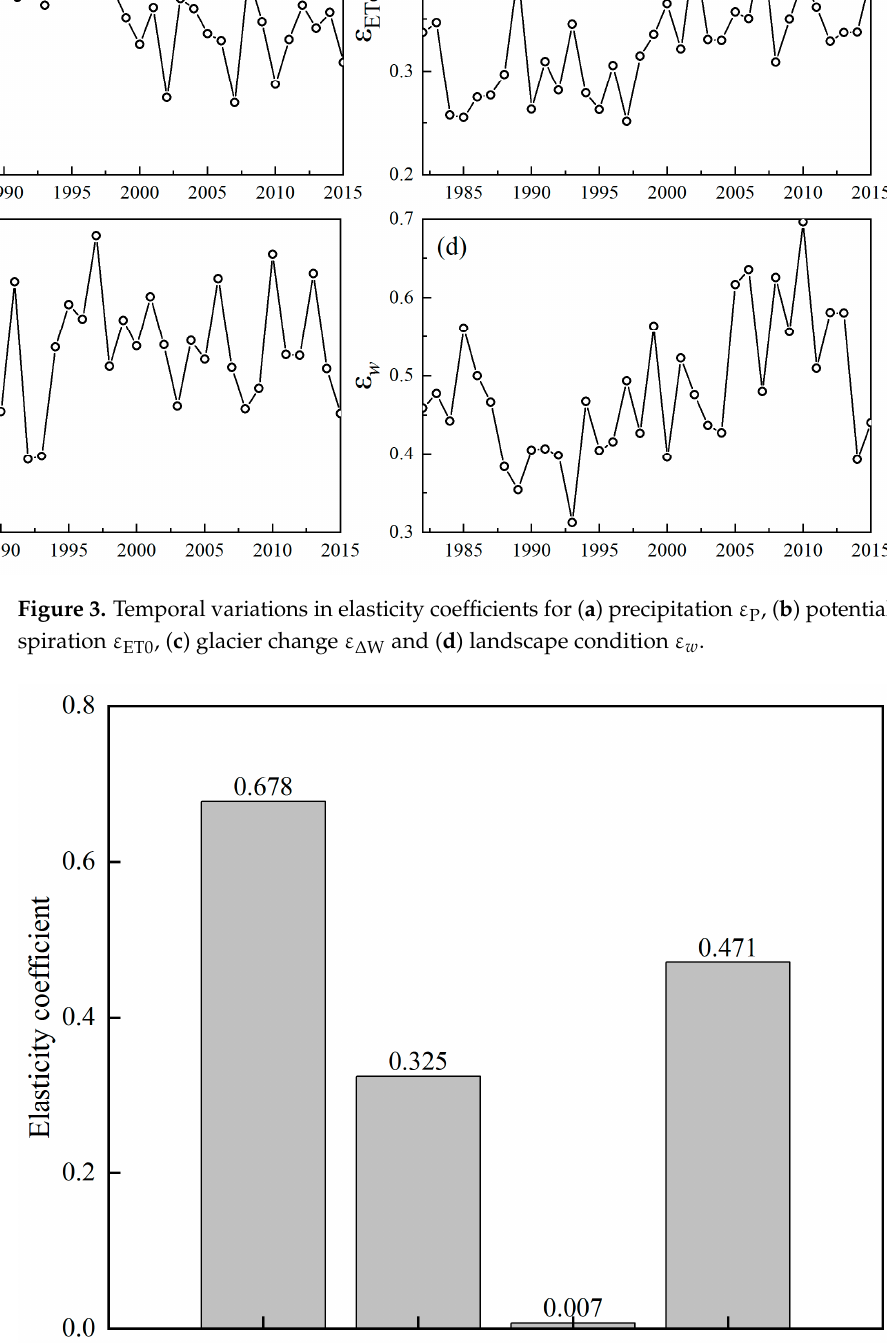
Figure 4. Elasticity coe ffi cients of ET to P, ET 0 , ∆ W, and w .